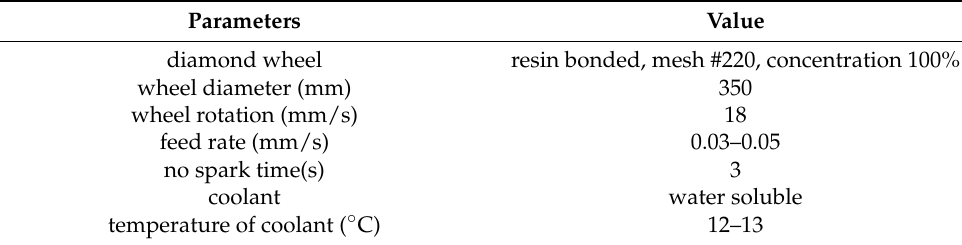
Table 1. Grinding conditions for